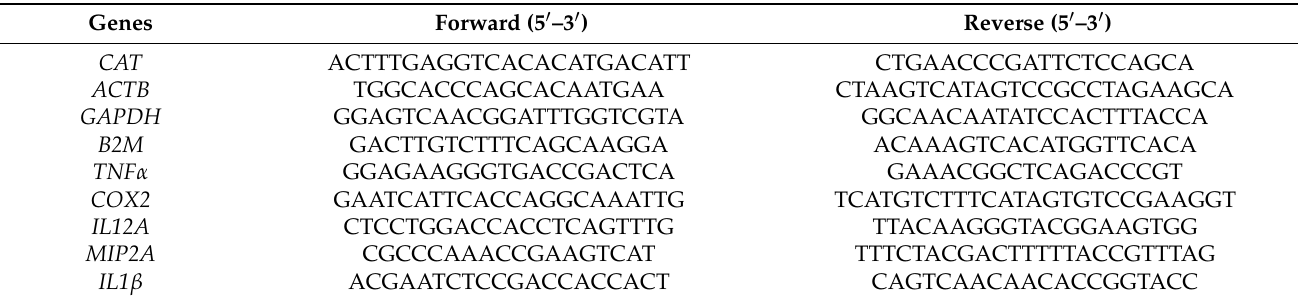
Table 1. Primers used in real-time PCR